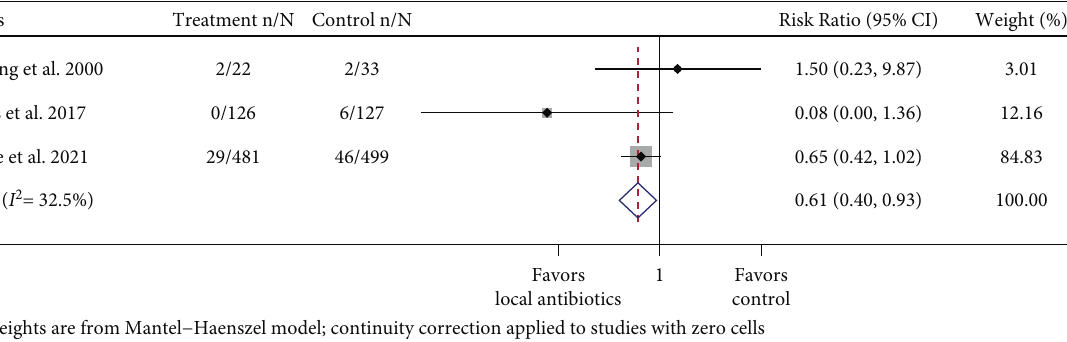
Figure 4: Forest plot of infection data of 3 fracture randomized controlled trials. Treatment n/N: number of infections in the treatment group/total number of patients in the treatment group. Control n/N: number of infections in the control group/total number of patients in the control group.